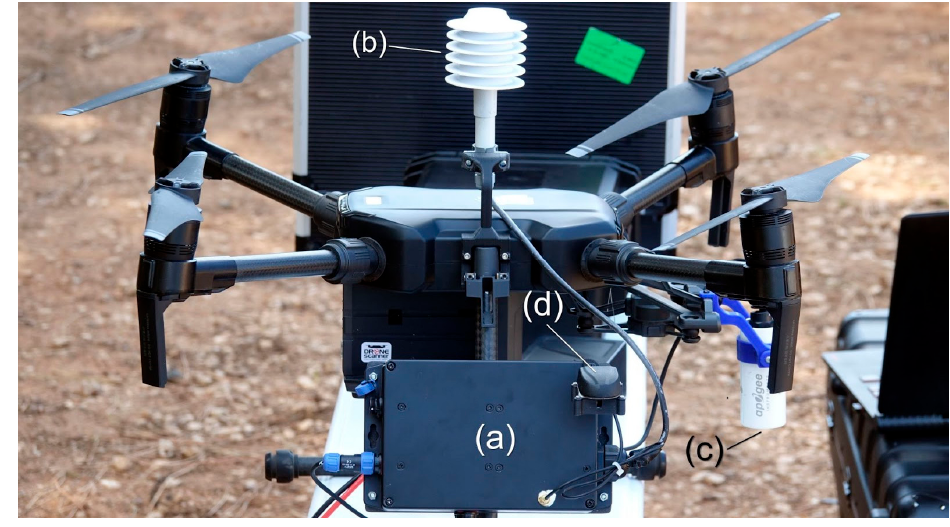
Figure 7. ( a ) Watertight box (data logger Stylitis-12 inside); ( b ) temperature and relative humidity (thermo-hygrometer) sensor in the radiation shield; ( c ) infrared sensor and the mounting base; ( d ) GPS sensor.